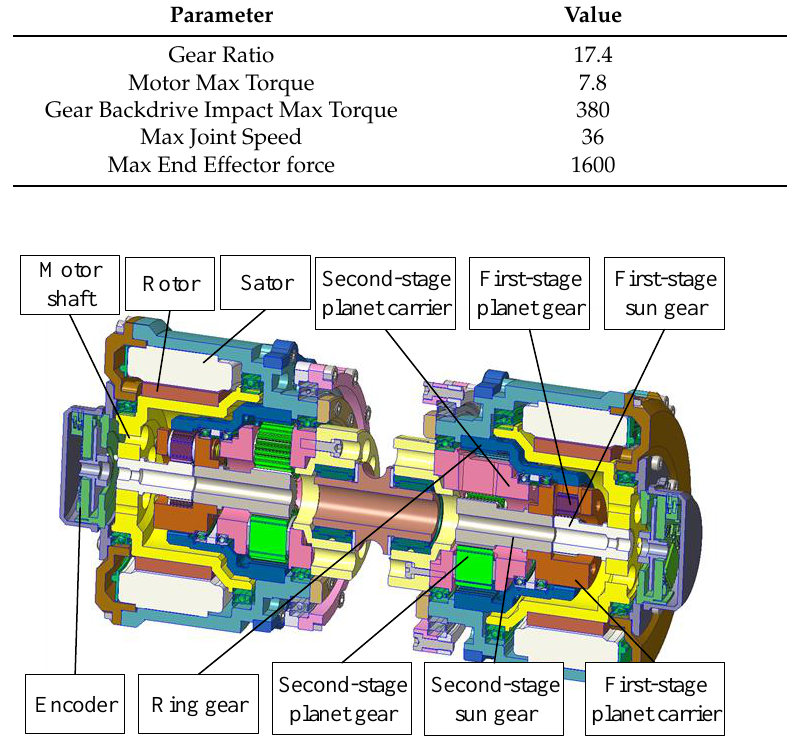
Figure 6. Actuator design. The actuator is designed with a custom motor and two-stage planetary gear for high torque